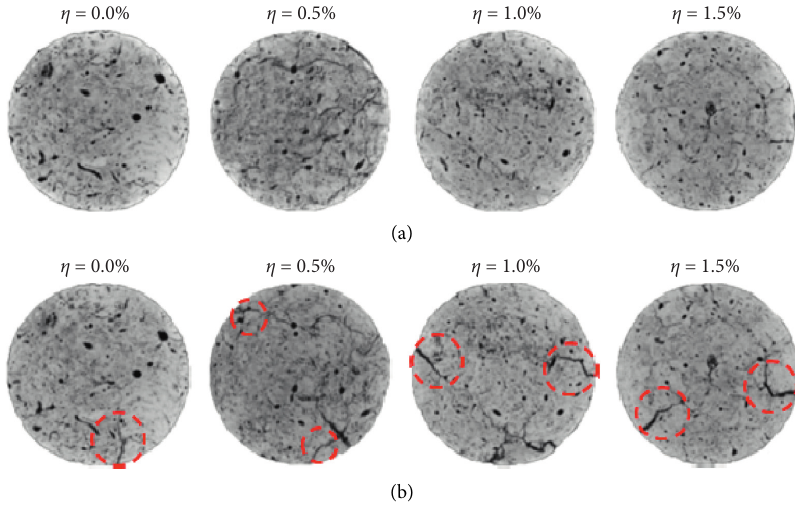
Figure 14: CT scan images of saline intact loess at various salt contents. (a) N � 0. (b) N �